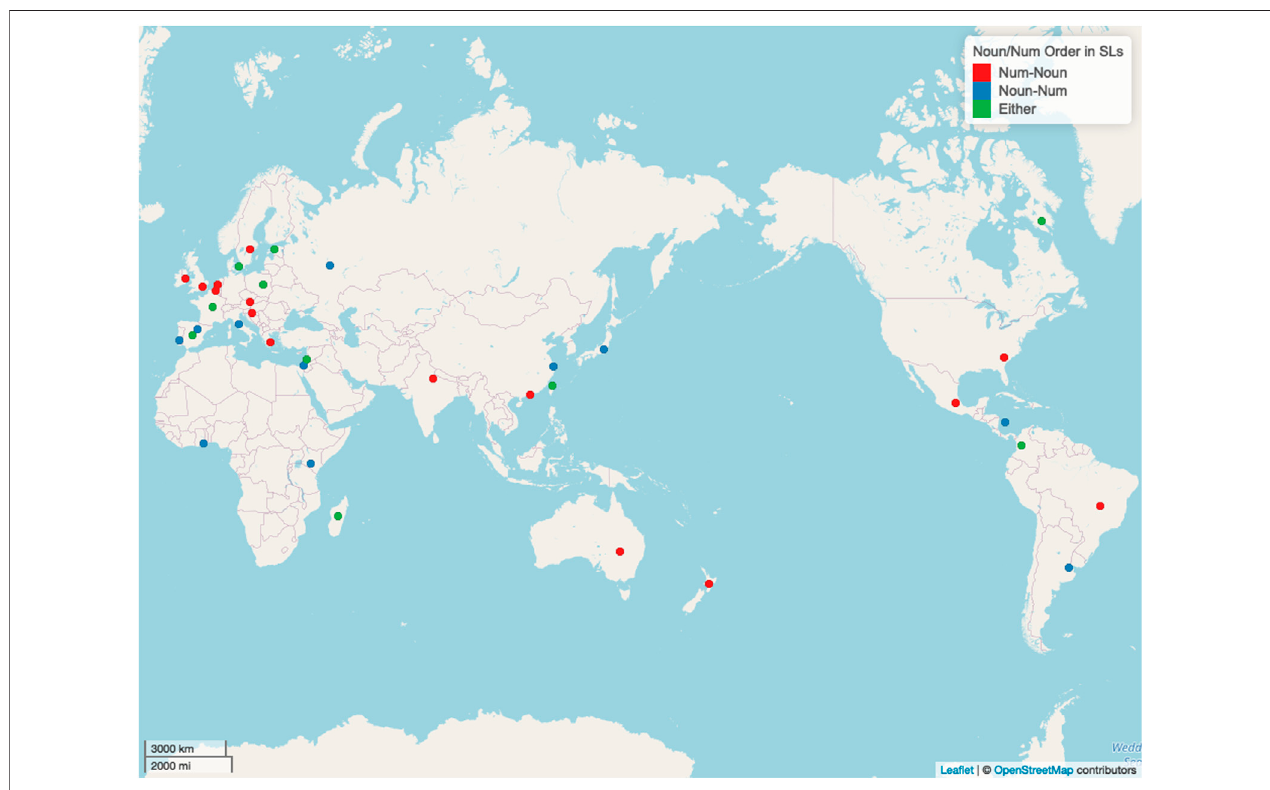
FIGURE 3 | Map of noun/numeral order in sign languages.